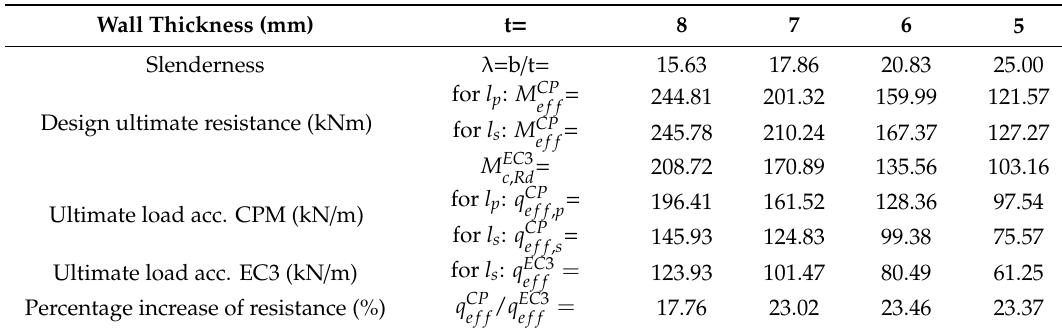
Table 3. Summary of ultimate resistance results according to CPM and EC3 for the I-300 × t × 250 × t section and four wall thickness